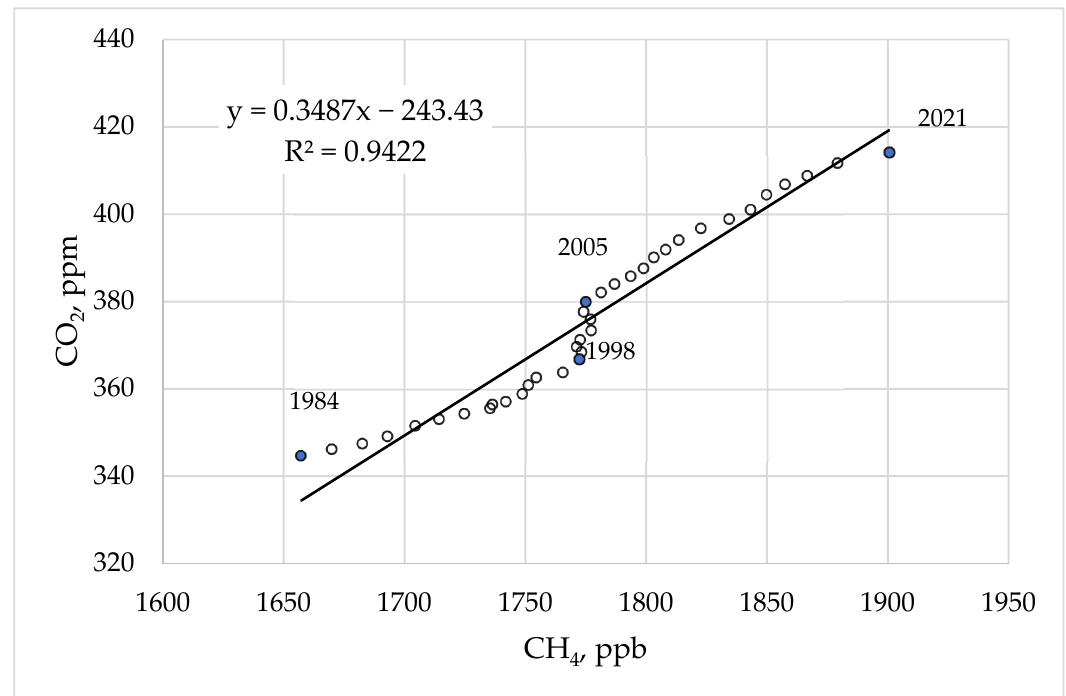
Figure 3. Correlation between CH 4 and CO 2 concentrations in the atmosphere from 1984 to 2021. The dataset was taken from [3].